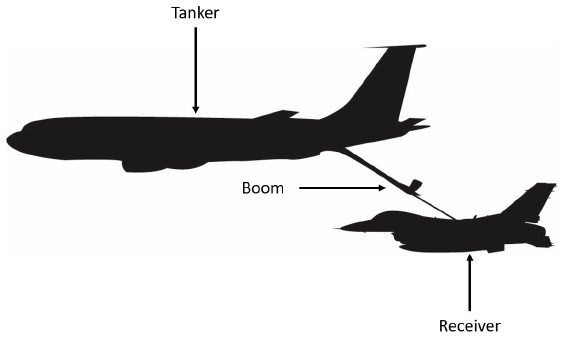
Figure 2. Example of boom-equipped refueling.